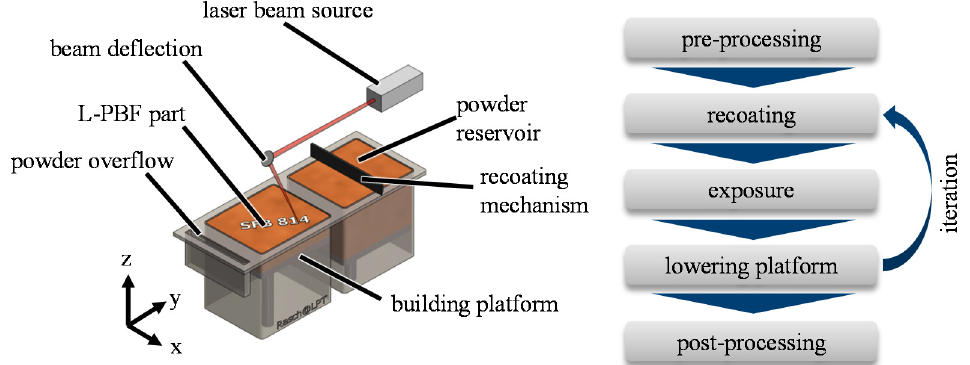
Figure 1. Schematic of the Laser Powder Bed Fusion (PBF-LB/M) process (reproduced from reference [13]).